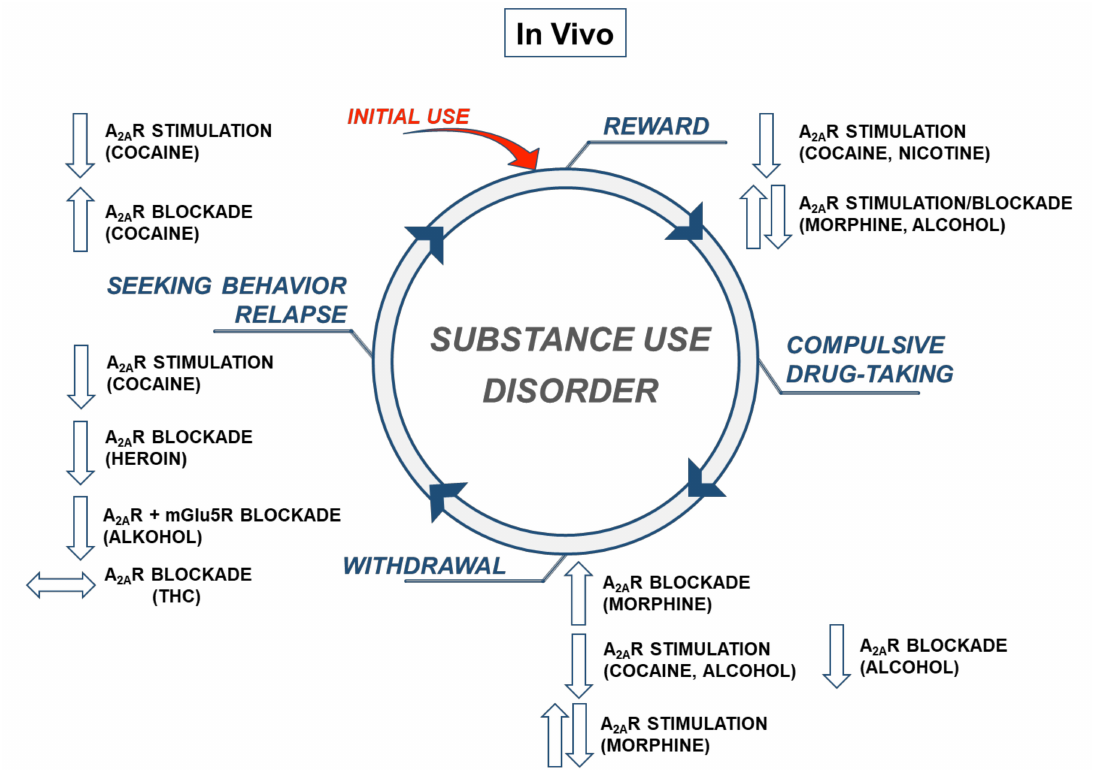
Figure 2. The diagram showing in vivobehavioral effects of stimulation or blockade of the adenosine (A)2A receptors in the cycle of substance use disorders. Up and down arrows indicate an increase or decrease in behavioral responses, respectively. Double-sided horizontal arrows indicate mixed effects on behavioral responses. mGlu5—metabotropic glutamatergic receptors type 5;